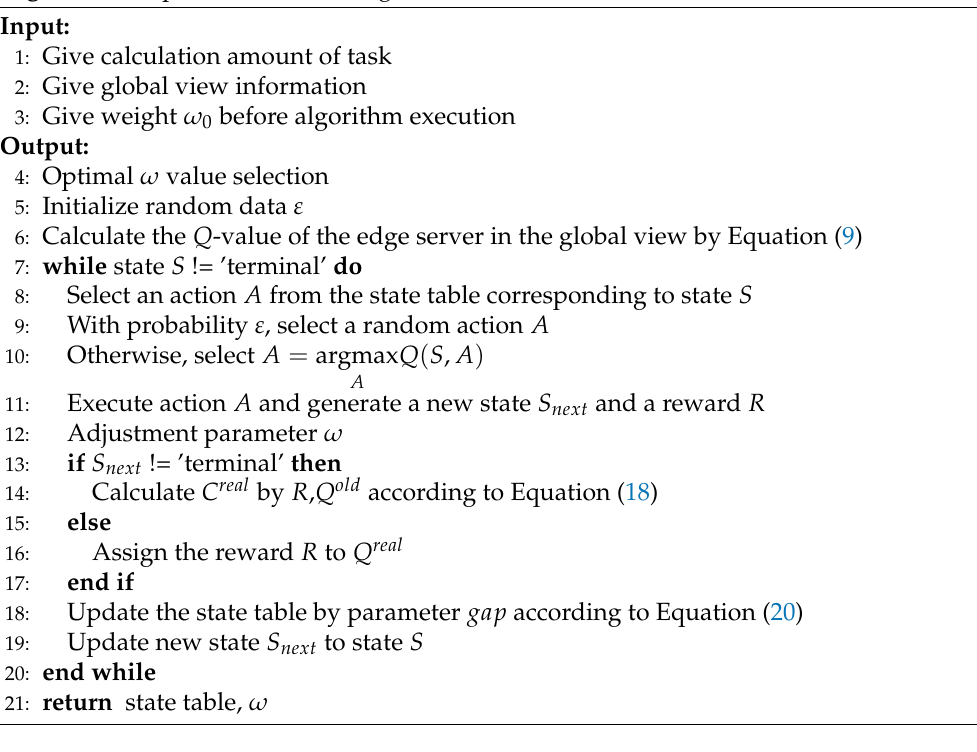
Algorithm 1 Optimal value find